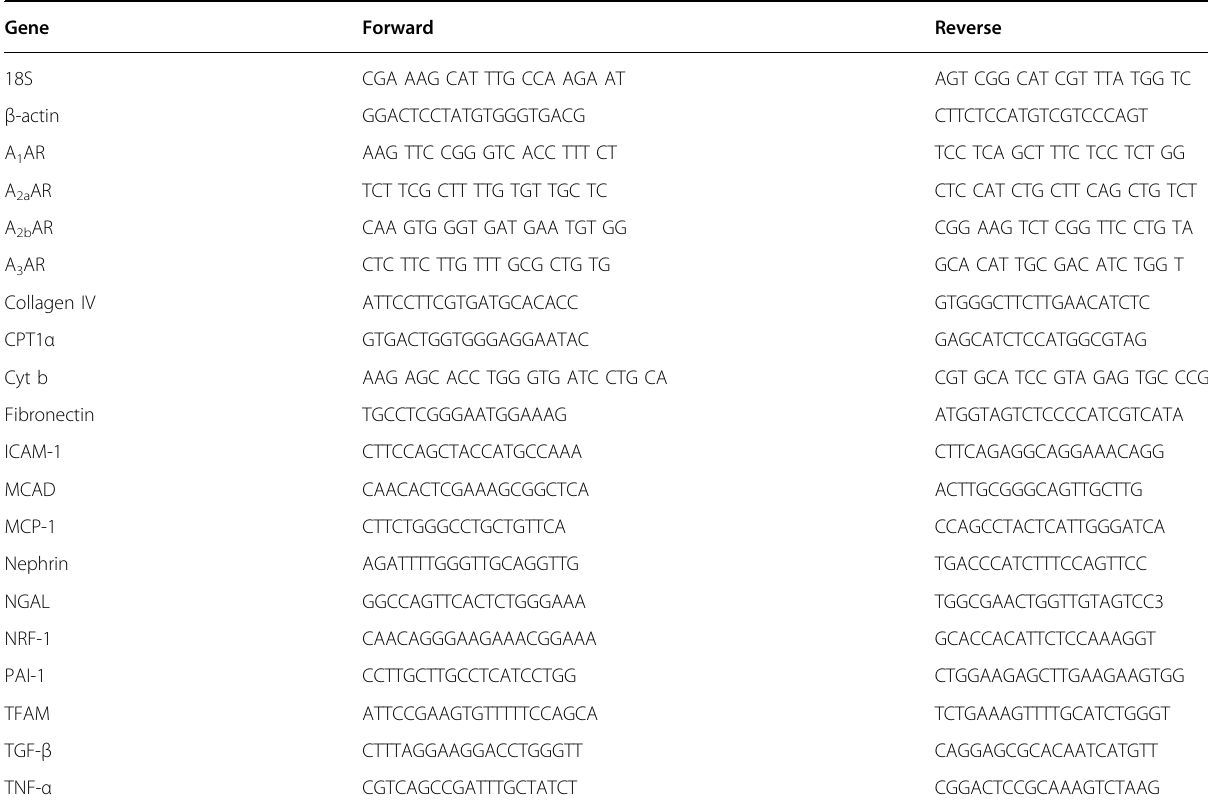
Table 1 Mice primer sequence used in the present study Gene